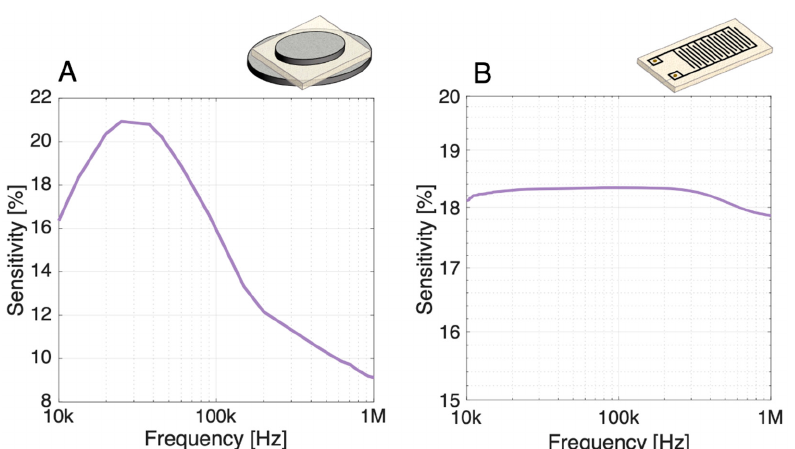
Figure 9. Spectral sensitivities of the ( A ) parallel-plate and ( B ) IDE setup towards 10 8 CFU mL − 1 B. thuringiensis cells in low salinity buffers. The sensitivity includes both contribution from the mod- ulus and the phase shift. The IDE sensitivity expresses their high response towards resistance changes through a plateau between 10 kHz and 0.3 MHz, while the parallel-plate sensitivity pre- sents a peak because of the interplay between R NC and C NC in the sensing mechanism.